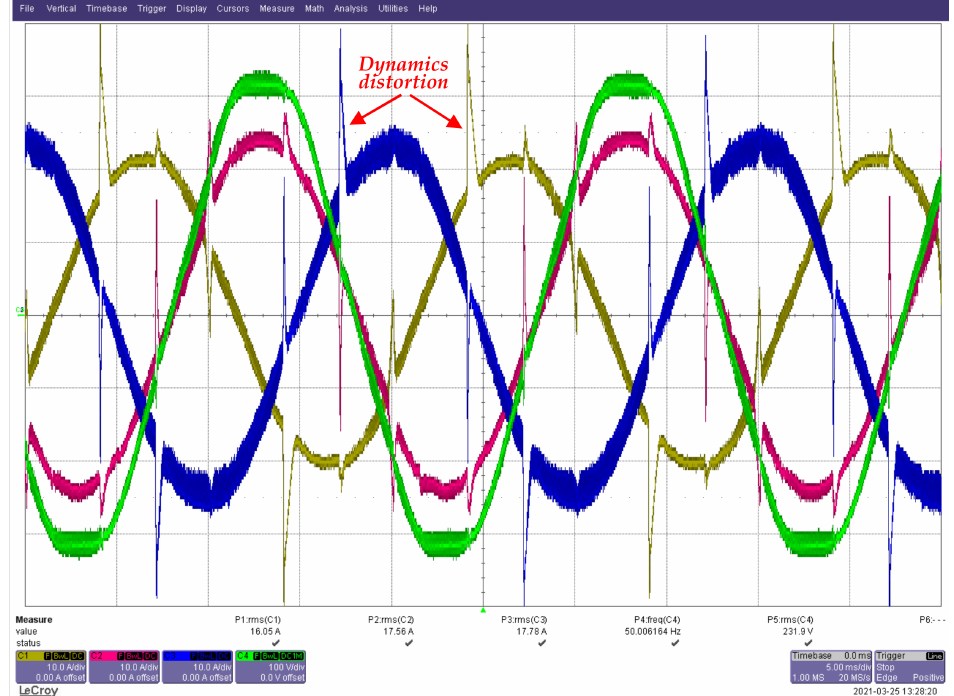
Figure 15. Exemplary experimental waveforms for fully controlled rectifier, APF is switch on, line currents: i M1 ( t ) (red), i M2 ( t ) (blue), i M3 ( t ) (yellow), and line voltage u M1 ( t )